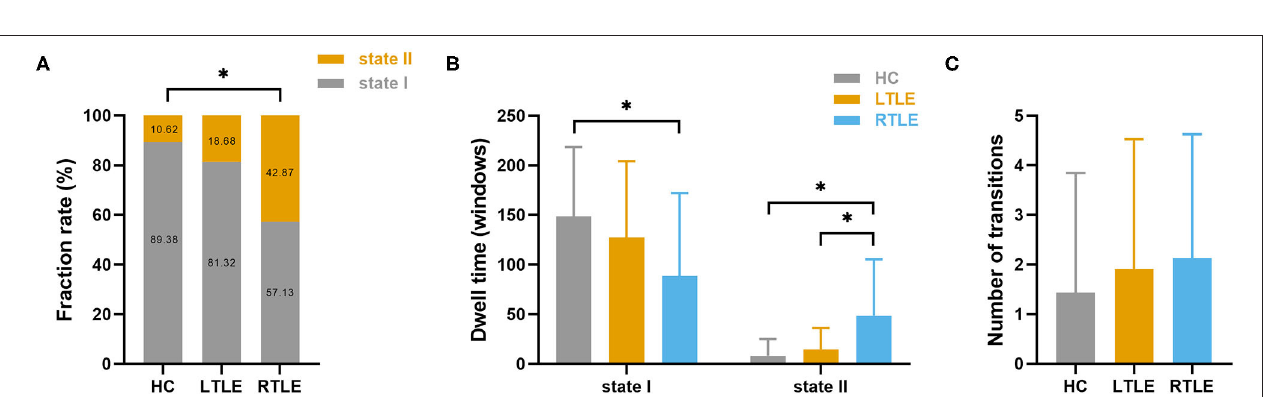
FIGURE 5 | Temporal properties and connectivity of the dynamic functional connectivity state. Group differences in the fraction rate (A) , mean dwell time (B) , and the number of transitions of each state (C) were measured. The horizontal lines above the bars indicate comparisons that achieved statistically significant thresholds (* P < 0.05, Bonferroni